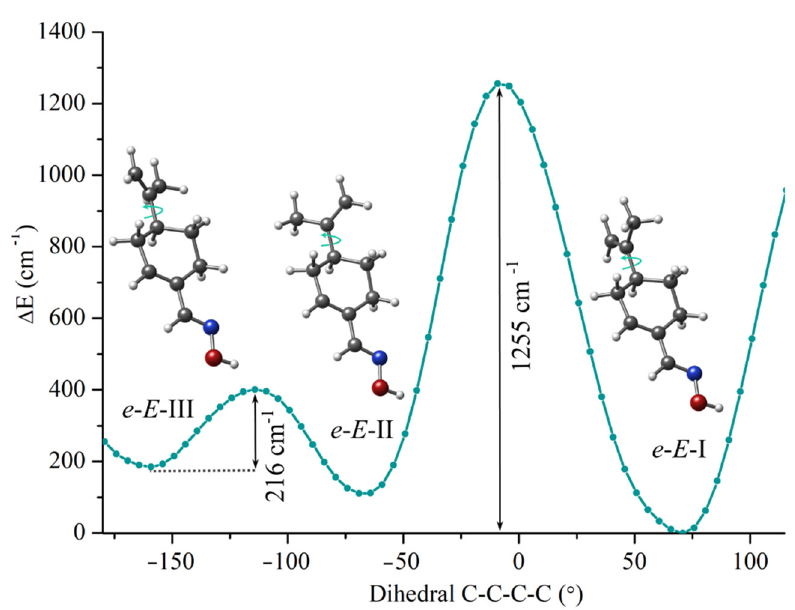
Figure 5. The isomerization relaxed potential energy barrier (PES) between the e-E-III / e-E-II / e-E-I conformers of perillartine computed at the B3LYP-GD3BJ/6-311++G(d, p) level, using the CH 2 -C-C-CH 3 torsion for the scan (as indicated using an arrow).